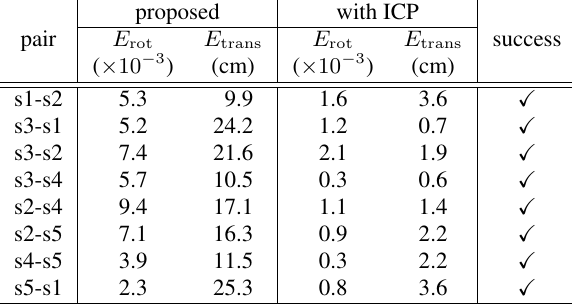
Table 2. Accuracy for Arch dataset